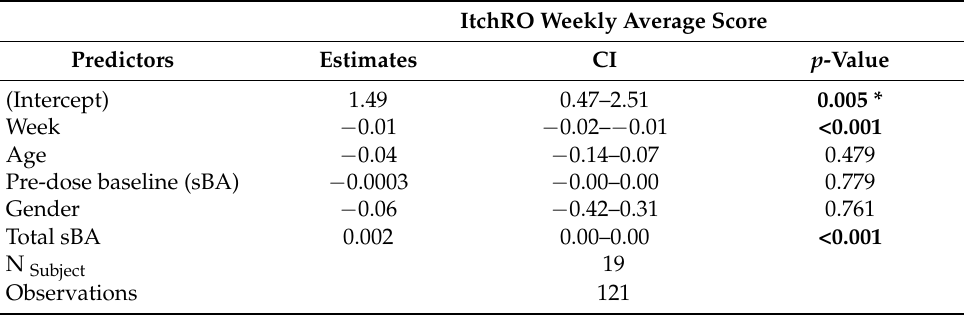
Table 2. Summary of linear mixed model (LMM) of ItchRO score ~ total sBA (uM). ItchRO Weekly Average